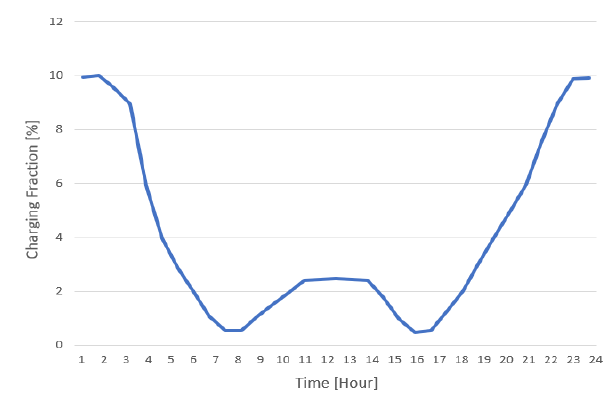
Figure 3. Hourly charging profile.